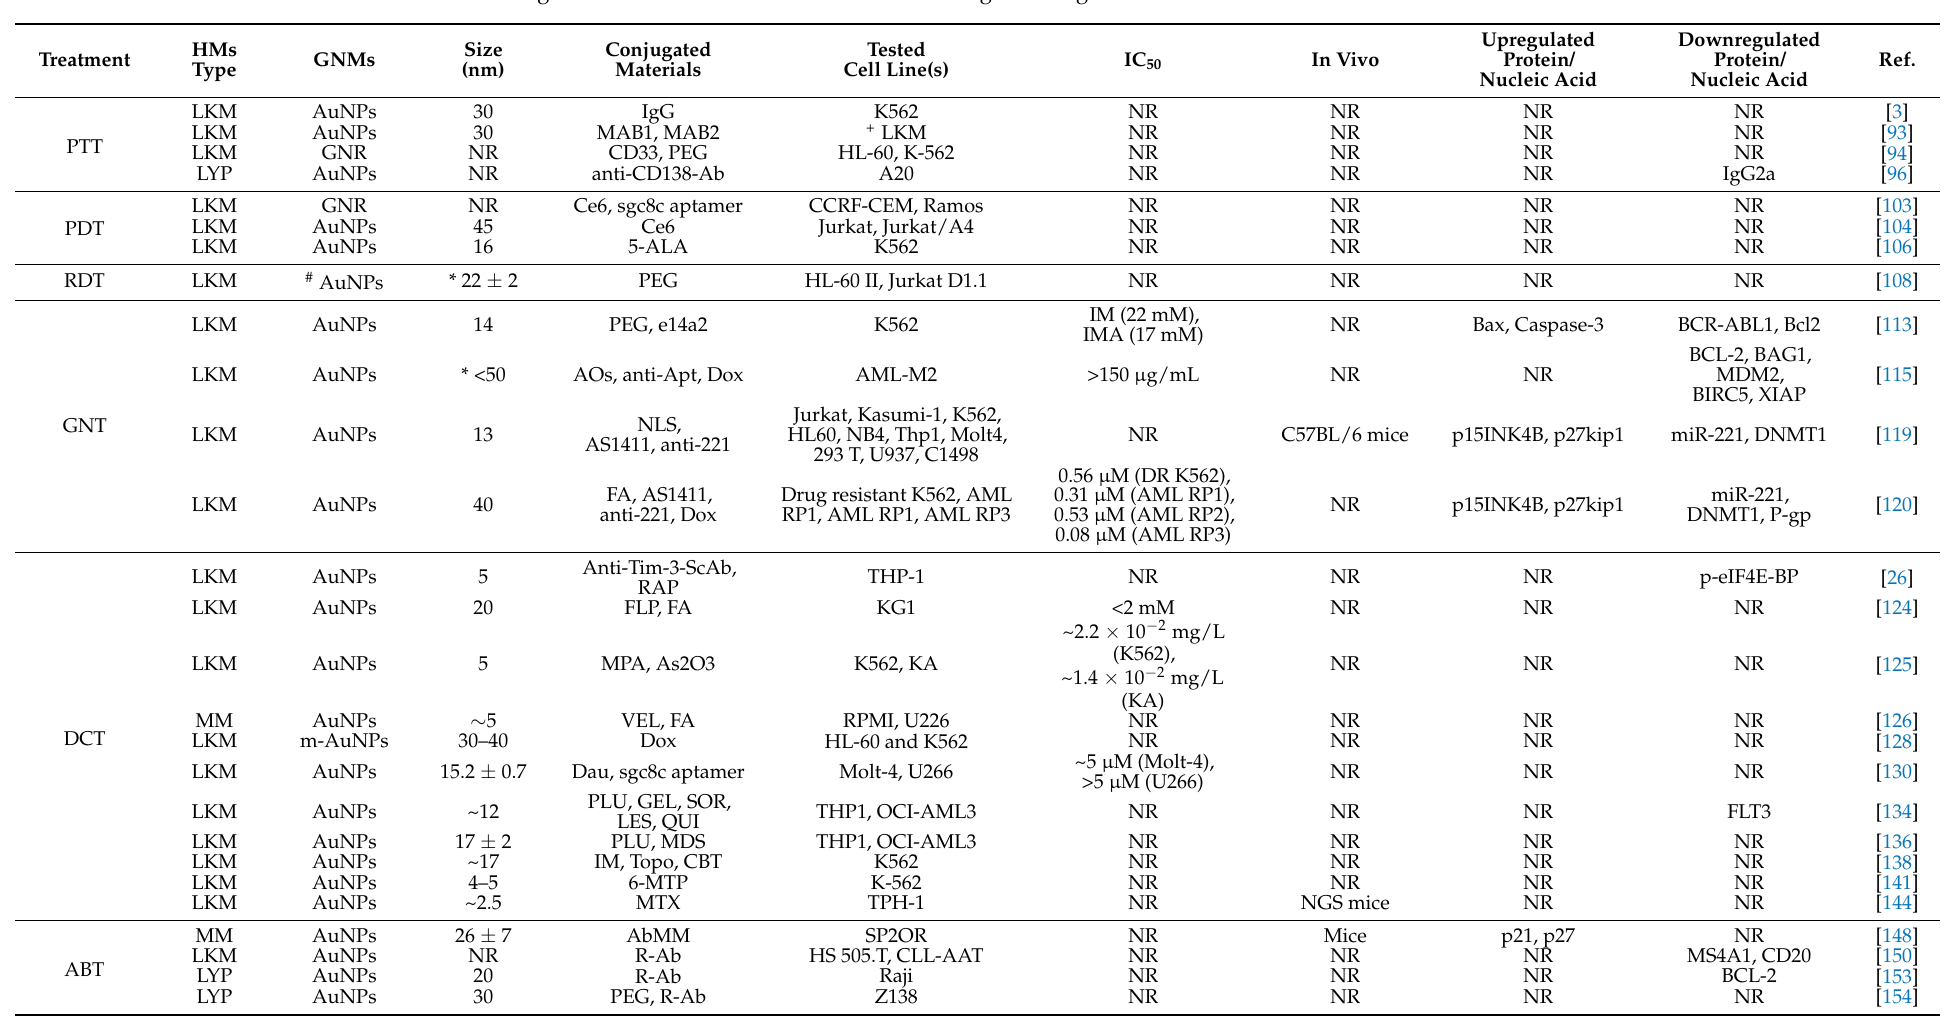
Table 4. Promise of gold nanomaterials in treatment of hematological